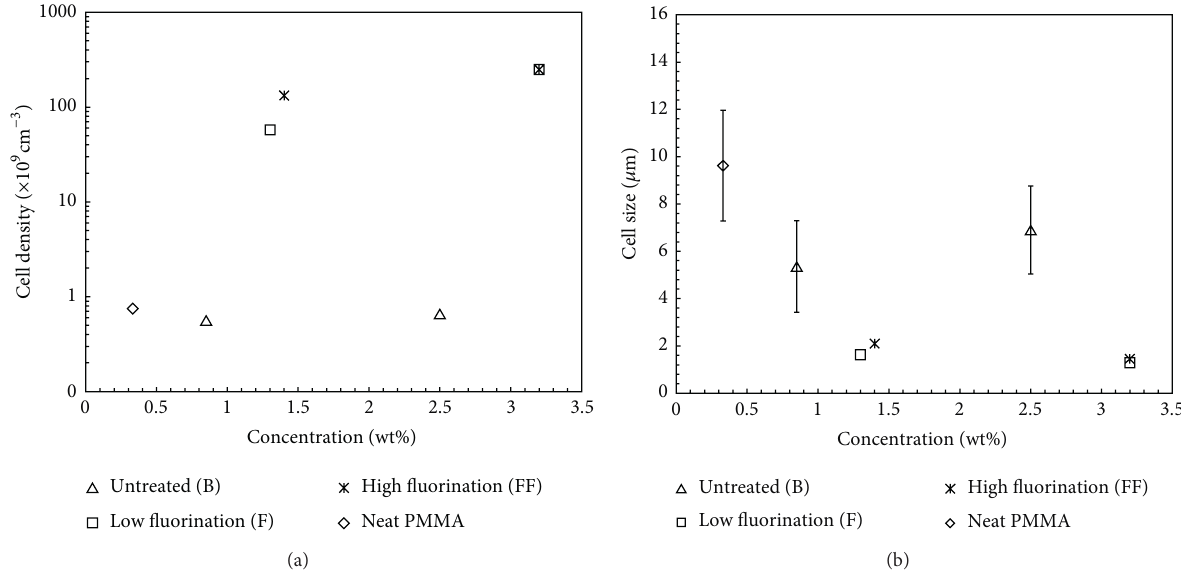
Figure 6: (a) Cell density and (b) average cell size of the neat PMMA, nanocomposites containing bare nanosilica (B), nanocomposites with surface treated silica at low fluorination (F) and high fluorination (FF). Error bars represent standard error of five samples and error bars smaller than symbol size are not